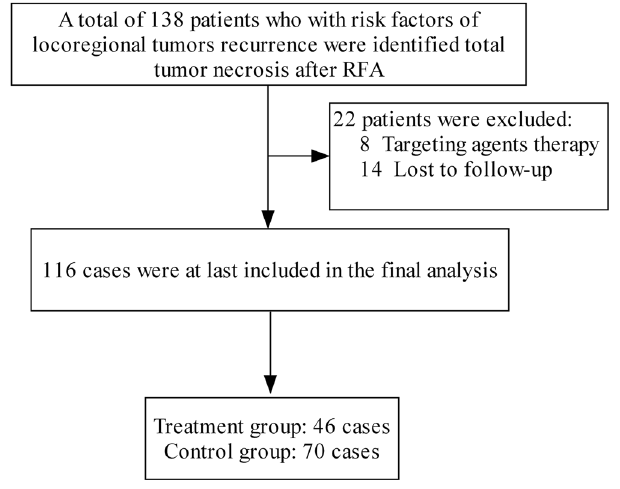
Figure 1. Selection of the